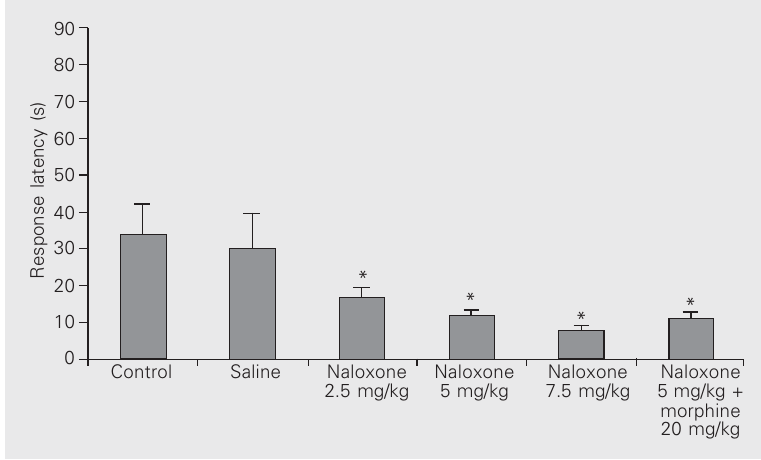
Figure 4. Effect of naloxone, naloxone plus morphine, and saline (1.0 ml) on the response latency after thermal aversive stimuli (50 º C) 15 min after injection. Data are reported as means ± SEM for N = 9 animals in all groups. *P < 0.05 compared to control and saline- treated groups (ANOVA followed by the Tukey test). No significant difference was ob- served between the groups treated with different naloxone